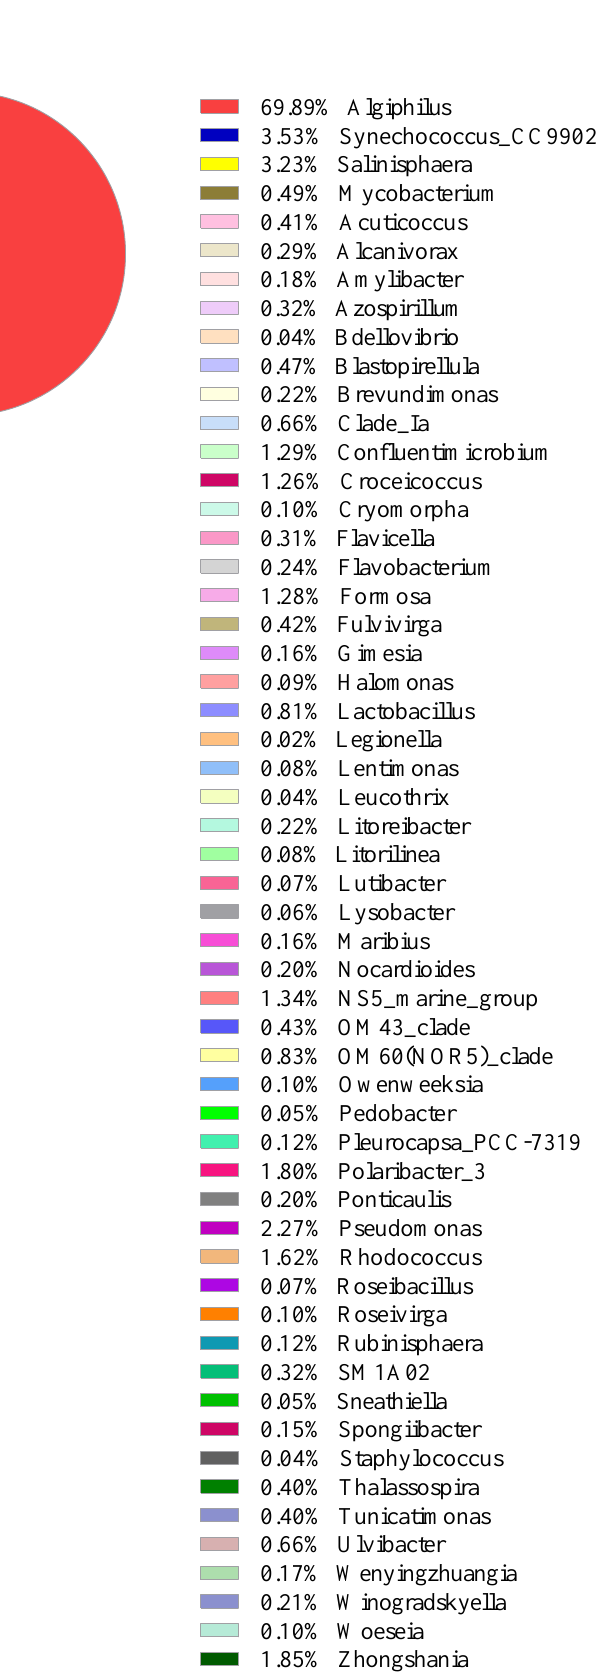
Figure 10. Free-living bacteria relative abundance by 16S-rRNA metabarcoding analysis. The water sample was collected from Metri, Chile (−41°5967′, −72°7056′) on 24 April 2019, from 0–10 m depth and filtered through a 0.2 μm pore-sized membrane. A total of 28,635 read pairs were obtained.